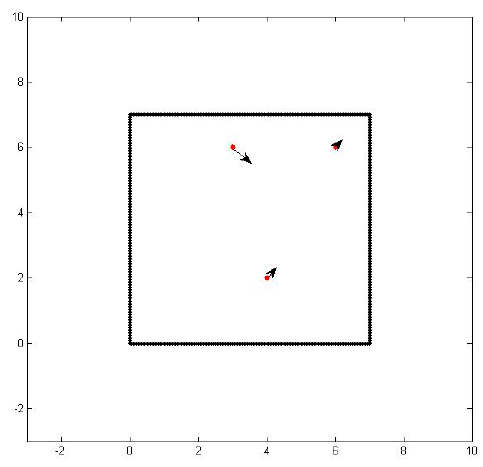
Figure 1. The location of three sensors in a square enclosure.